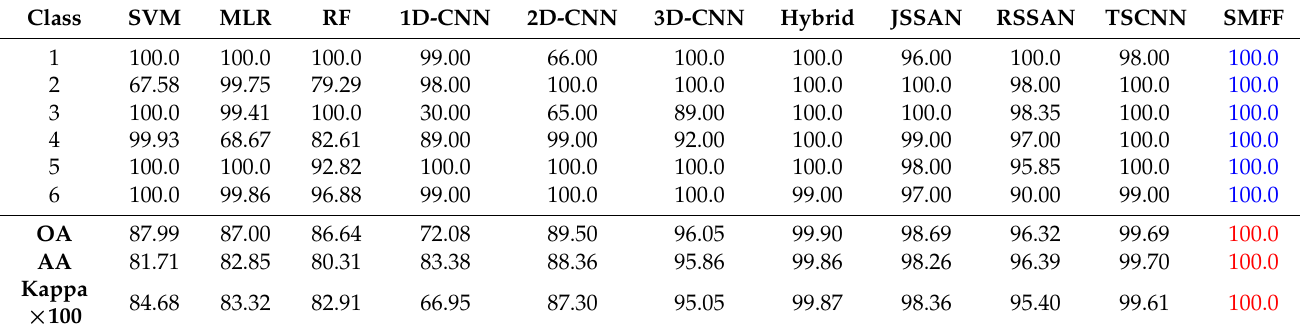
Table 8. Classification results of different methods for the SA